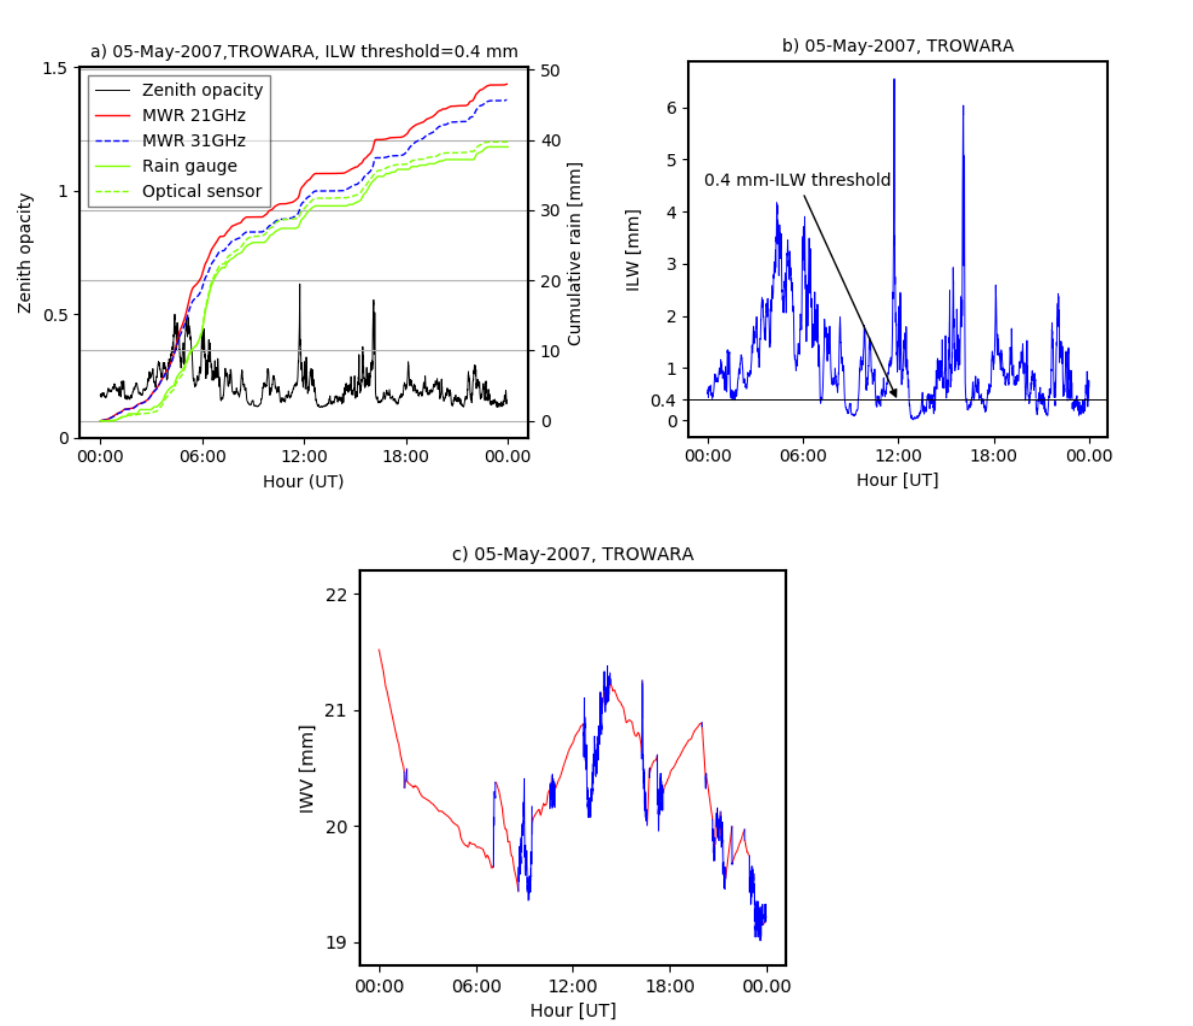
Figure 1. Example of a rain day at Bern (5 May 2007). ( a ) Zenith opacity at 31 GHz (black line) and cumulative rain (blue and red) measured by TROWARA. The solid and dashed green lines are cumulative rain observed by the rain gauge and the optical sensor respectively. ( b ) ILW observed by TROWARA. The ILW threshold of 0.4 mm separates between rain and rain-free periods. ( c ) IWV observed by TROWARA. During rain periods (ILW ≥ 0.4 mm), IWV is indicated by the red line. The blue line shows IWV during rain-free